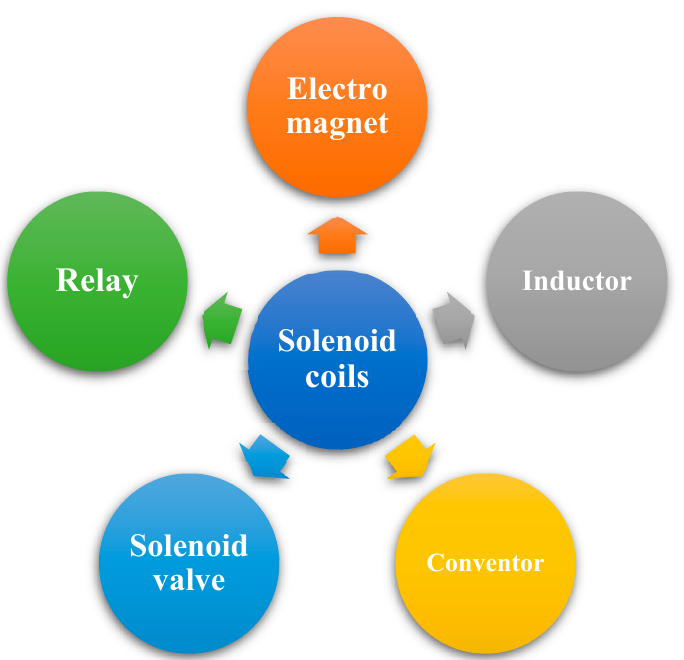
Figure 2. Main applications of solenoid coils as common electromagnetic components.